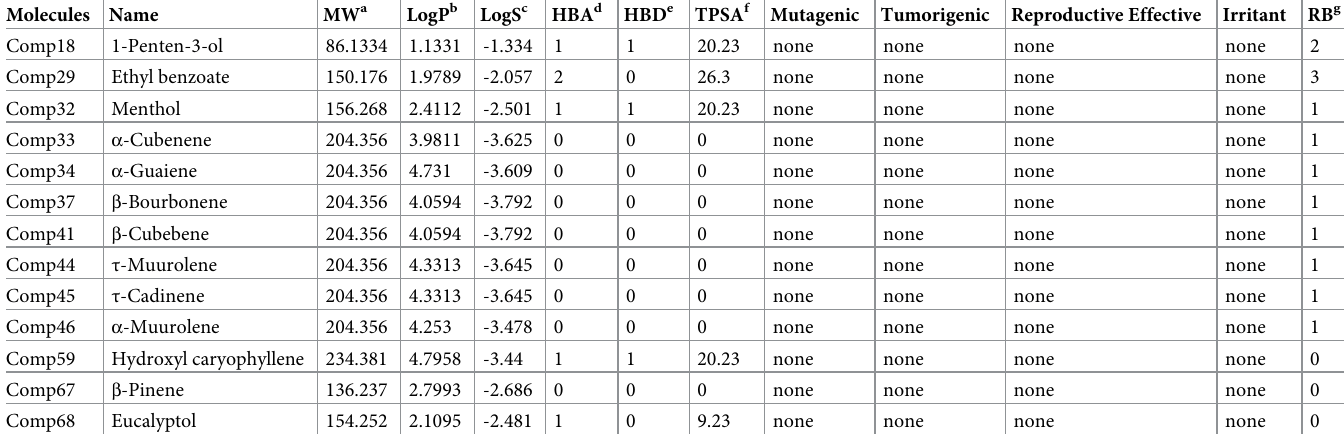
Table 1. Physicochemical properties of the thirteen selected bioactive compounds derived from F . carica . Molecules Name